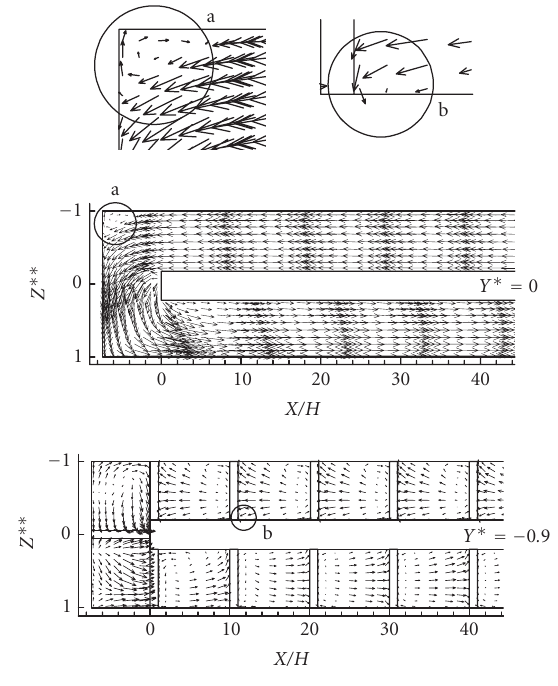
Figure 2: Mean velocity vector plots in Y ∗ = 0 and − 0 . 9 planes for Ro = 0 . 15 and Re = 1 . 0 × 10 4 .